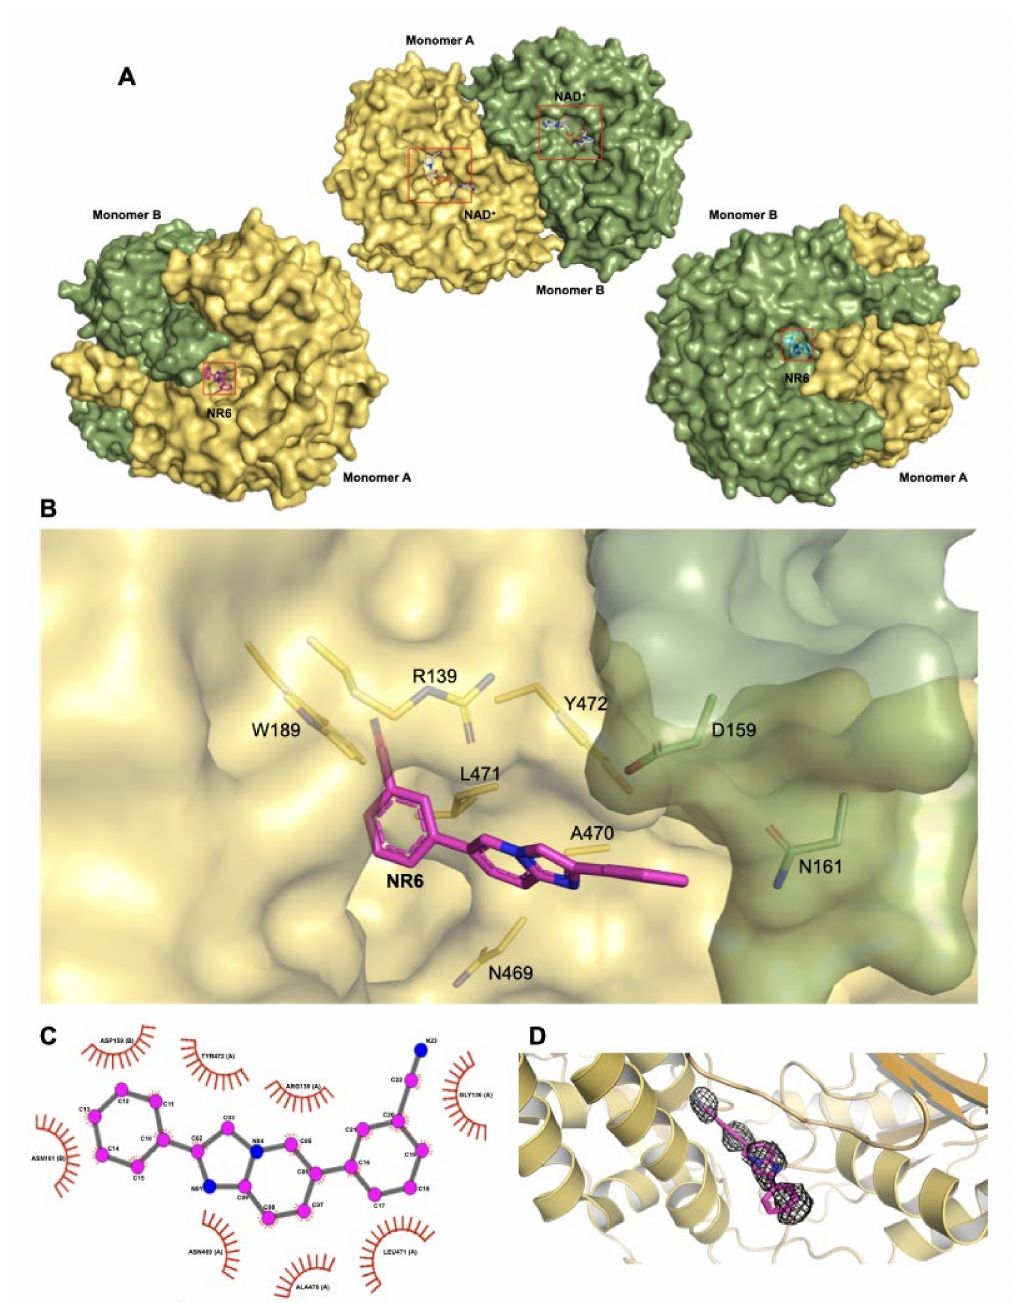
Figure 2. Structural analysis of ALDH1A3 in complex with NR6 ( A ) Representation of both monomer (A and B) as a surface, both are bonded with one molecule of NAD + and one molecule of NR6, that are lodged with the same orientation. The inhibitor occupies only partially the entrance of the catalytic tunnel in both monomer; ( B ) Focus on the NR6 binding site: all side chains of the residues implicated in the NR6 binding are highlighted as sticks. The 2-phenyl ring and the backbone of the residues D159 and N161 from monomer B interact each other. ( C ) LigPlot+ analysis of the complex between NR6 and ALDH1A3, all the major interactions are hydrophobic, due to the nature of the molecule and the aminoacidic supply of the protein in that specific region. ( D ) NR6 2mFo-Fc map (isomesh = 0.8 carve =